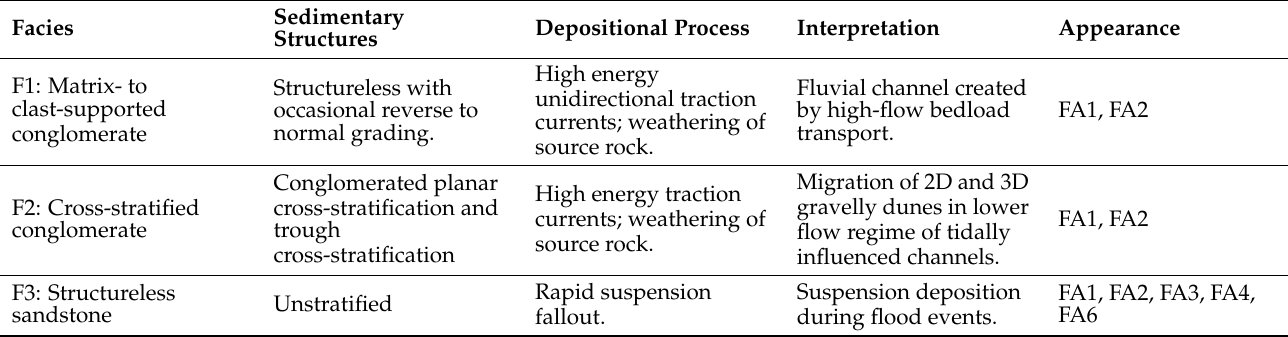
Table 1. A summary of facies and facies associations including sedimentary structure descriptions, depositional processes involved and depositional